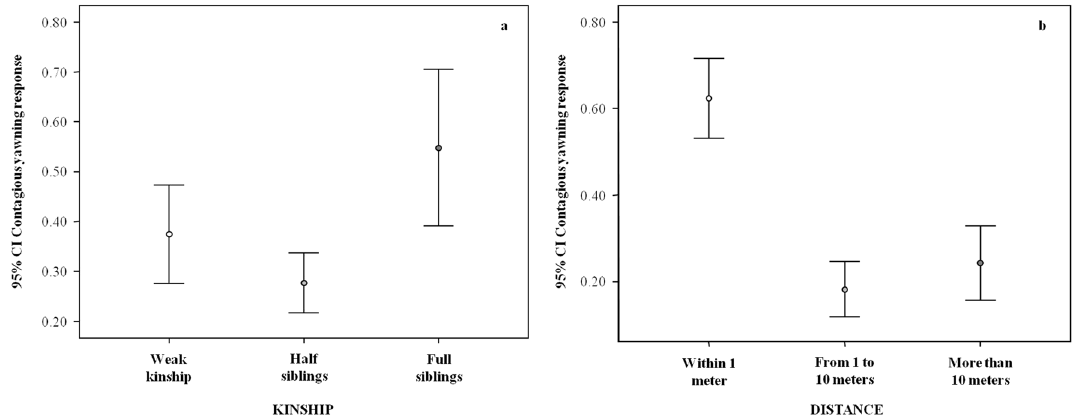
Figure 5. Error bars (mean, 95% confidence interval) showing the occurrence of yawn contagion (Y axis) as a function of social factors (X axis): kinship ( a ) and inter-individual distance ( b ). Both variables have a significant main effect on yawn contagion (results of Model 2 included in Table 2), which was highest ( a ) between full siblings (Tukey post-hoc test with Bonferroni correction, full siblings versus other kinship: 0.031 ≤ p ≤ 0.033; Table 2) and ( b ) when the distance was within 1 m (Tukey post-hoc test with Bonferroni correction: within 1 m versus other distances: p < 0.05; Table 2). No significant association between the two nominal fixed factors kinship and distance was detected (Goodman and Kruskal’s lambda test: λ = 0.010, T = 0.200, p = 0.841). CI confidence